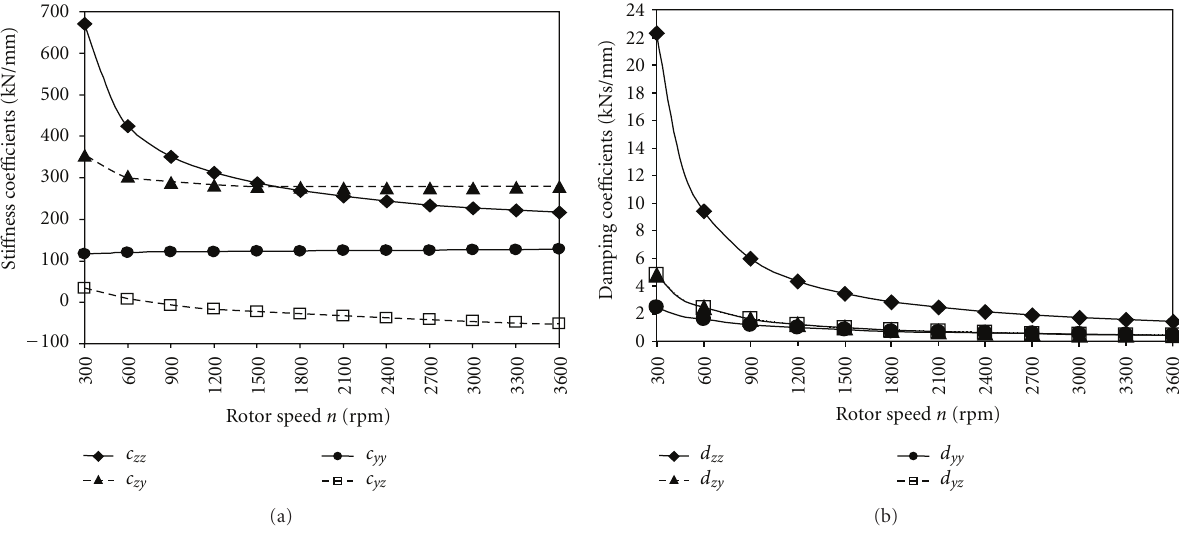
Figure 7: (a) Oil film sti ff ness coe ffi cients. (b) Oil film damping coe ffi cients.